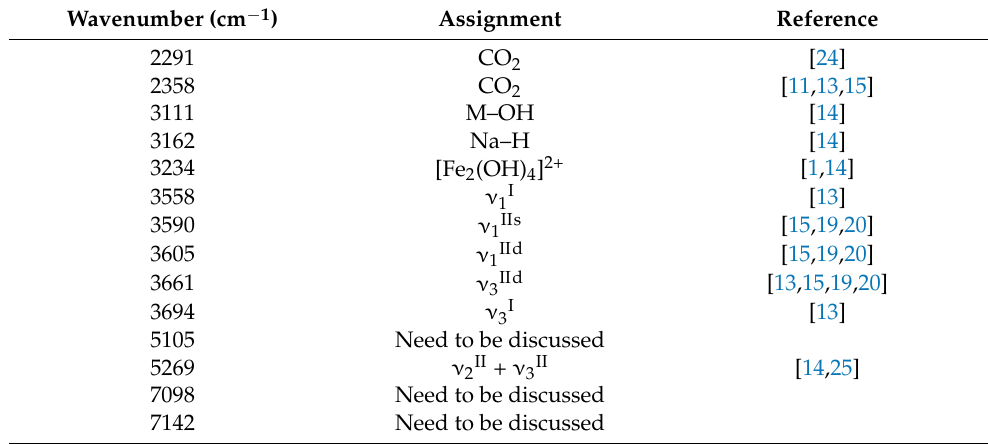
Table 1. Characteristic absorption peaks and assignment within 2000–8000 cm −1 .